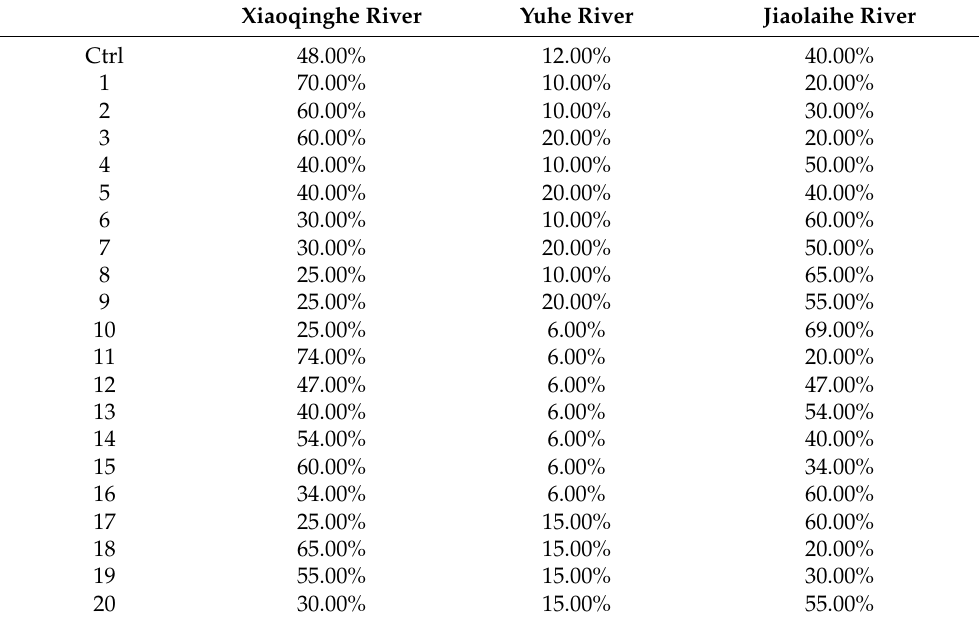
Table 4. Experimental schemes of pollutant